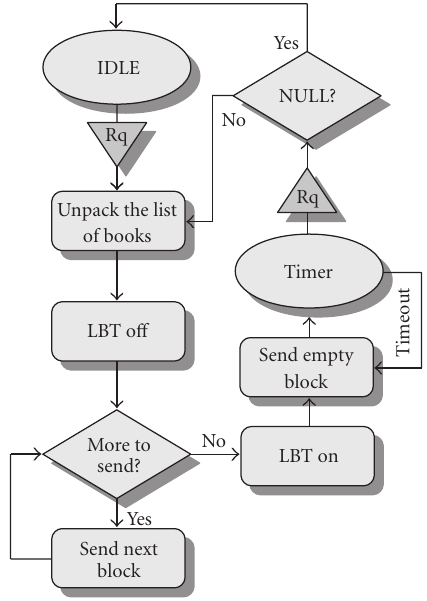
Figure 5: The transmission part of the protocol.